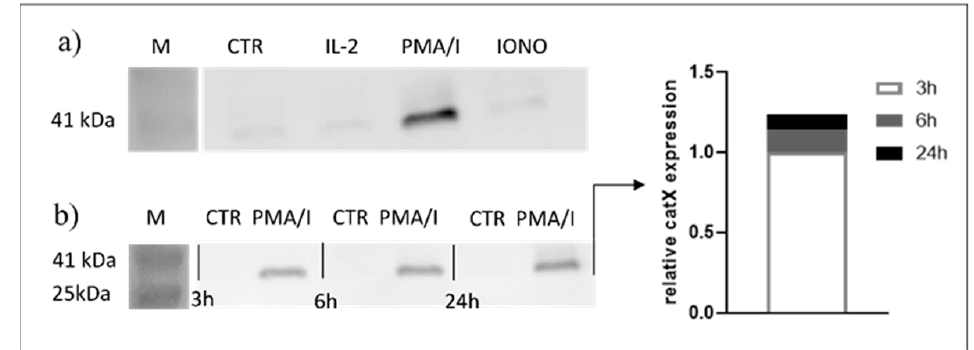
Figure 2. Only activated NK-92 cells secrete cathepsin X. NK-92 cells were seeded in SFM and treated with vehicle (CTR), IL-2, IL-2 plus PMA/IONO or IONO. After the indicated time points, the cell-culture supernatants were collected, concentrated with ultrafiltration and assayed for the presence of cathepsin X by Western blot. Only PMA/IONO-activated NK-92 cells abundantly secreted cathepsin X during 24 h incubation ( a ) and the majority of cathepsin X was secreted in the first 3 h after stimulation ( b ).